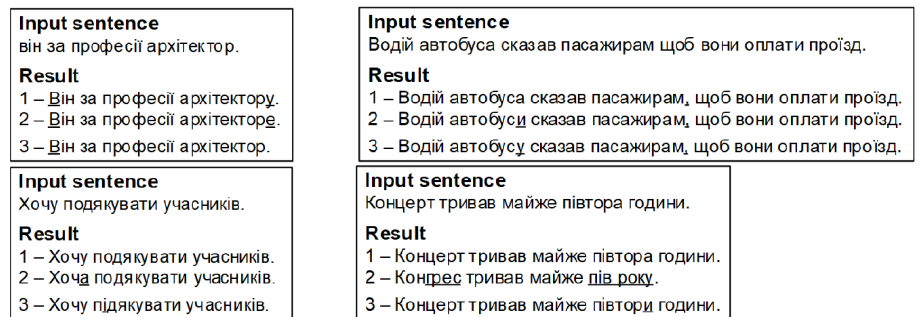
Figure 19. Variants of correction by different neural network models.